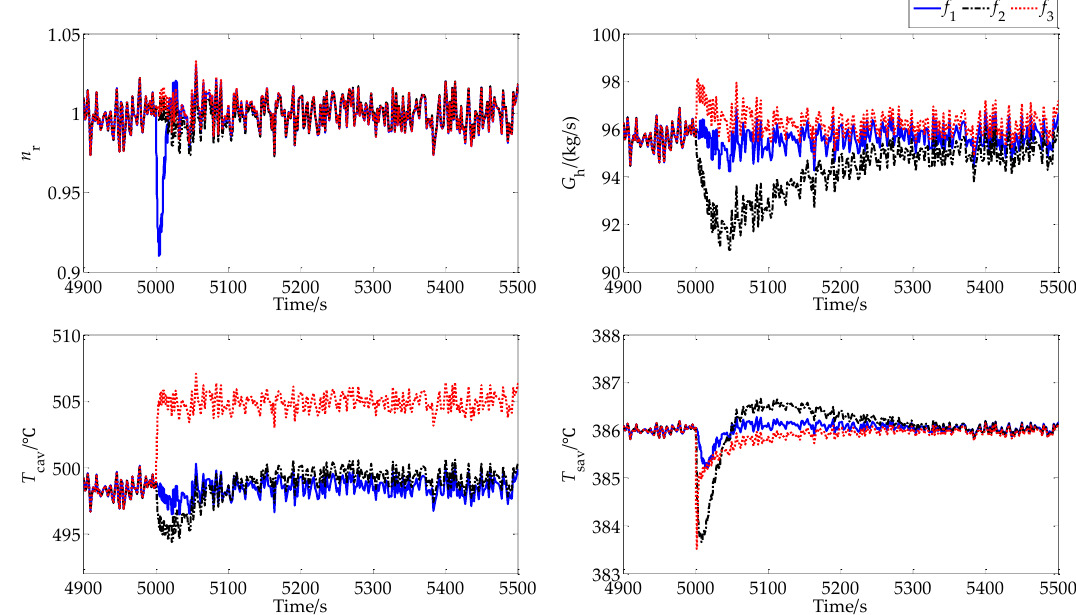
Figure 4. Dynamic responses of the MHTGR-based NSSS under faults f i ( i = 1, 2, 3); n r : normalized nuclear power, G h : primary helium flowrate, T cav : average helium temperature, T sav : average temperature of the OTSG secondary